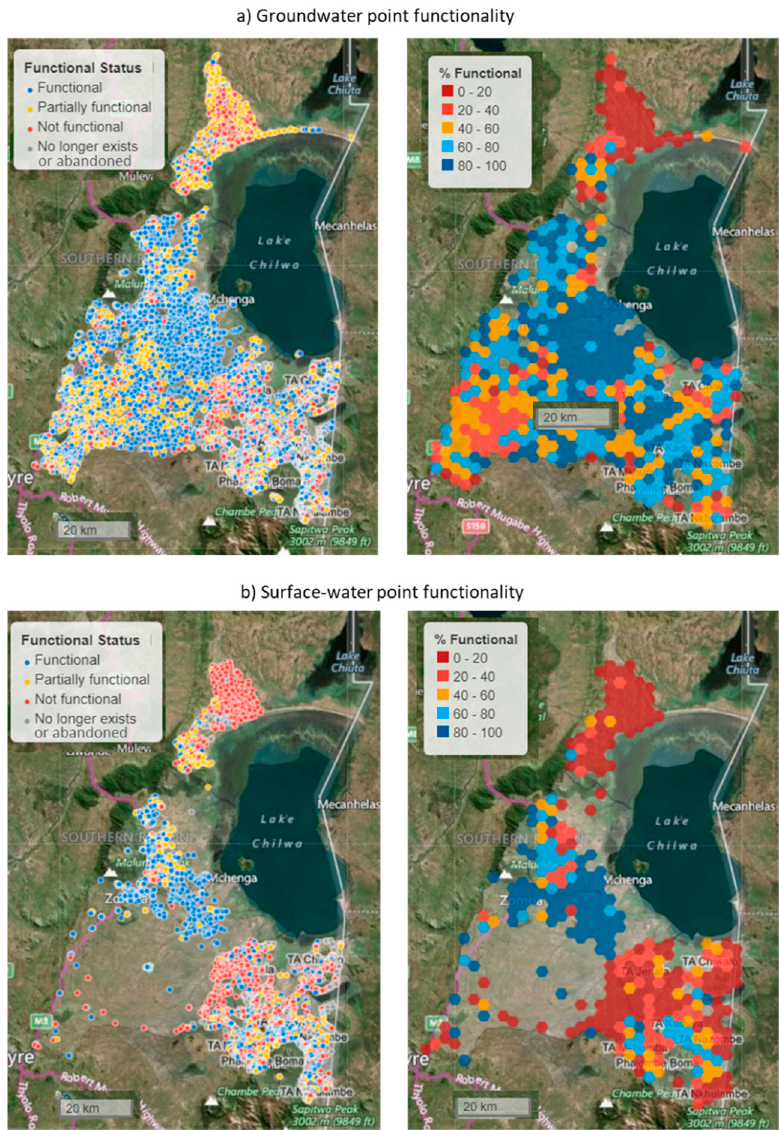
Figure 14. Lake Chilwa Basin (WRA 2) spatial distribution of current (2019) functionality of ( a ) groundwater-sourced water points and ( b ) surface water-sourced water points shown for individual water points (left panels) and percentage functional of hexagonal pixel area ( c . 2.5 km diam.).